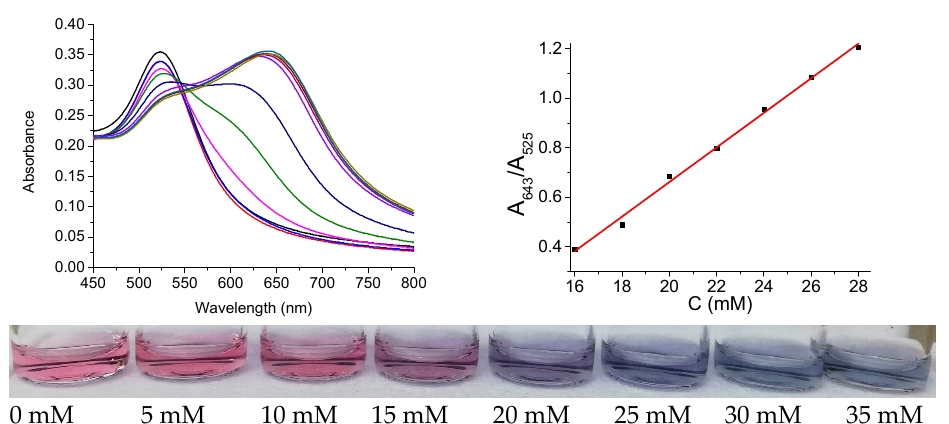
Figure 3. ( Top ) Titration of GHB ranging from 0 to 35 mM with GNP1 ( left ) and its linear regression ( right , y = (0.0698 ± 0.0019)·x − 0.74 ± 0.04, R 2 = 0.996), using deionized water as solvent. ( Bottom ) Colorimetric changes observed during the titration.